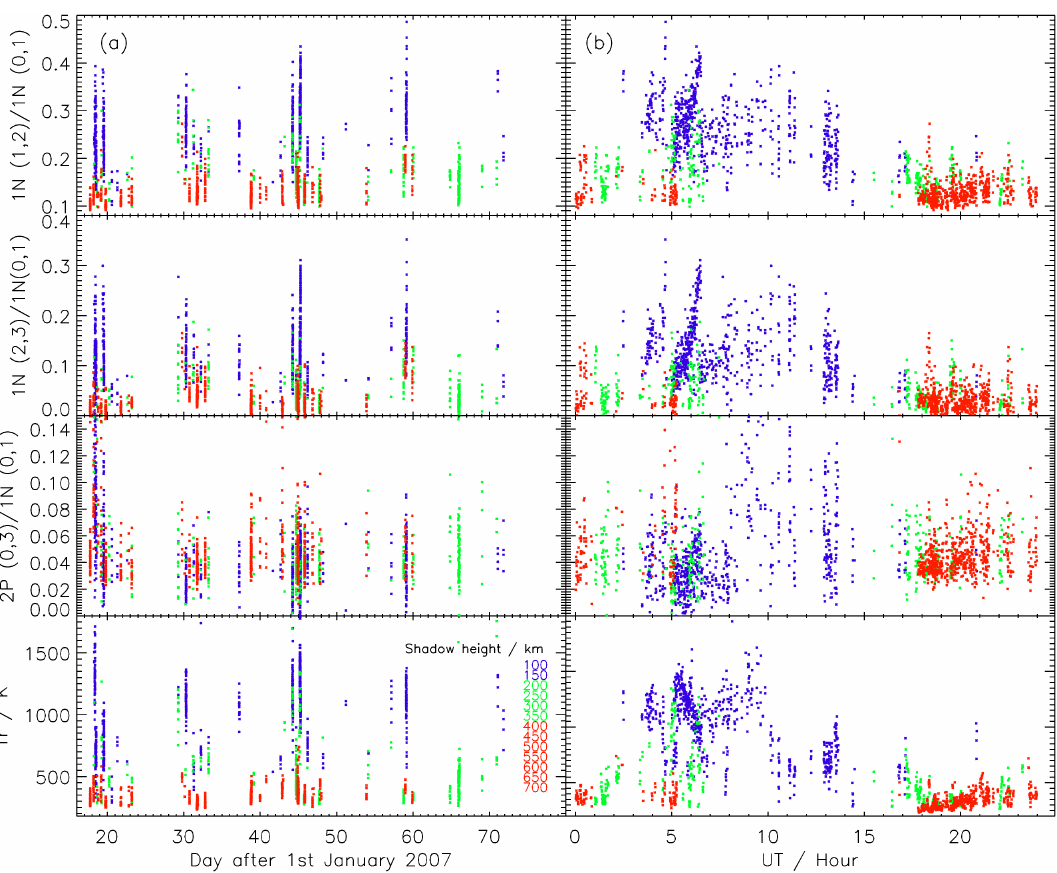
Fig. 11. (a) Ratios of N + 1N (1,2)/(0,1), (2,3)/(0,1), N 2 2P (0,3)/1N (0,1) and rotational temperature as a function of number of days since 2 1 January 2007. Solar shadow height (excluding screening height) is shown in colour. (b) Ratios of N + (0,3)/1N (0,1) and rotational temperature as a function of universal time. Solar shadow height (excluding screening height) is shown in